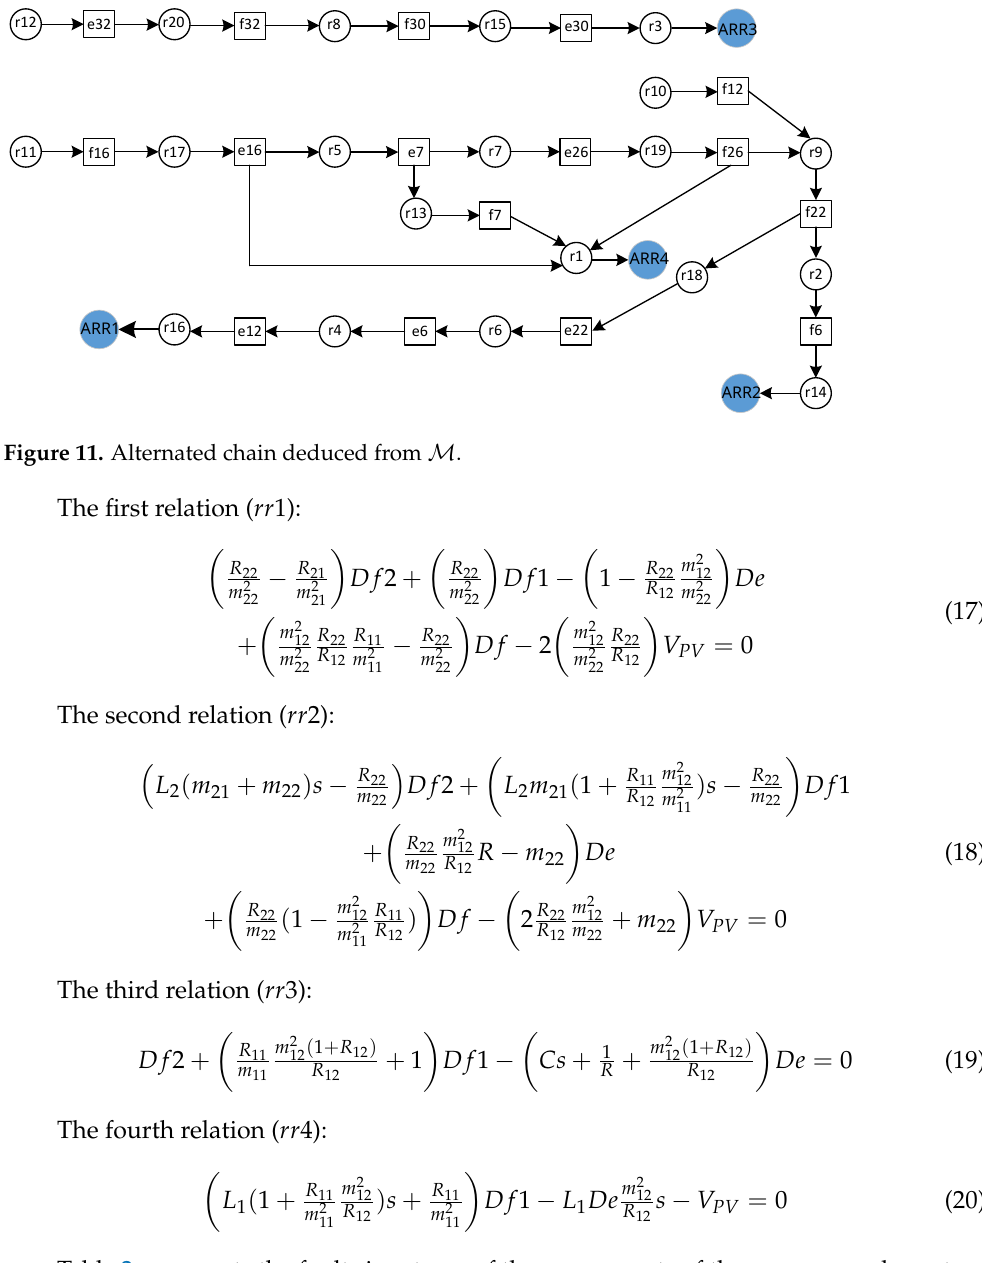
Table 2 represents the fault signatures of the components of the power supply system.